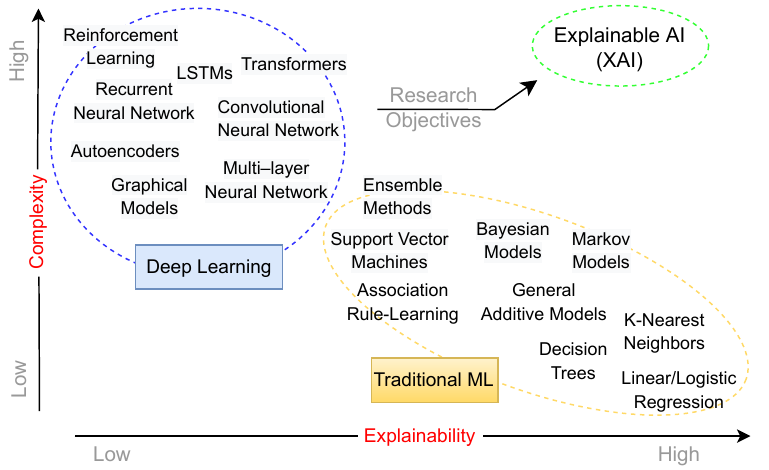
Figure 1. Classification of AI models according to their level of complexity, explainability, and their potential in modern AI